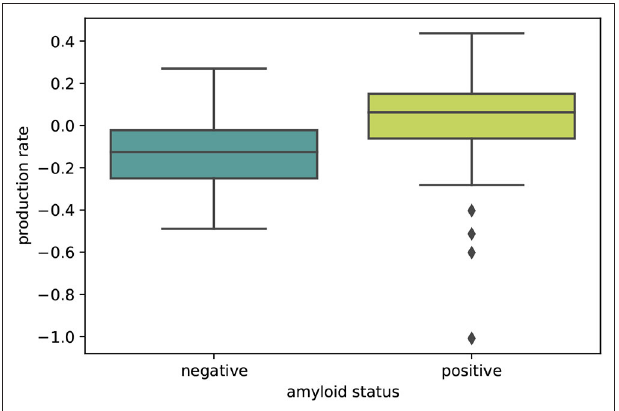
FIGURE 5 | Amyloid status. Boxplot illustrating the distributions of personalized production rates in amyloid negative and amyloid positive subject groups. The difference between the two groups is significant with p = 0.0075.